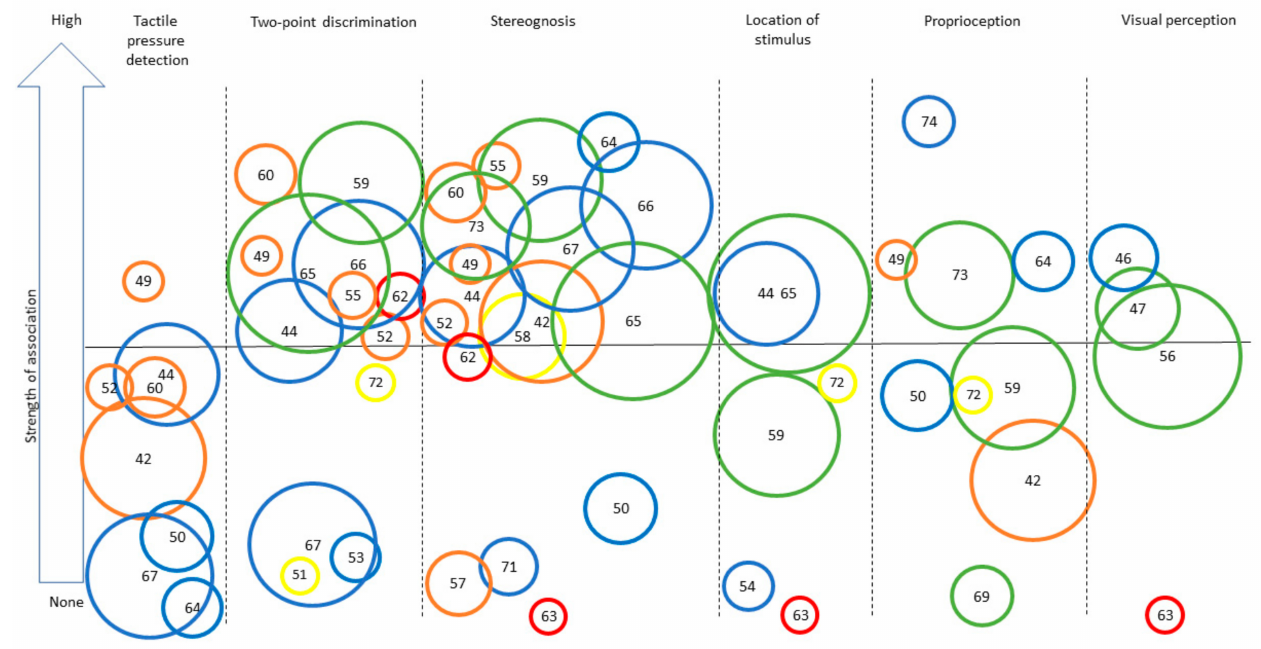
Figure 2. Synthesis of the strength of the association found across studies assessing different sensory outcomes in relation to unilateral motor performance. Legend: Each number represents an article (as identified in the references list). Only categories with more than three articles for UMF are represented to ensure legibility. Level of evidence is represented by the circle color: Green = very high quality study, blue = high quality study, orange = moderate quality study, yellow = low quality study, red = very low quality study. Size of the circle represents the number of participants included in each study (for example, a larger circle means more participants were included) numbers for Figures 2 and 3: [42], Arnould et al. (2014);